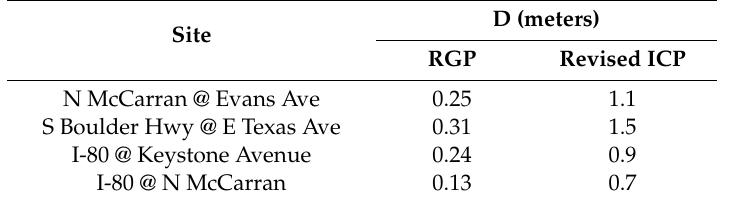
Table 2. Performance evaluation.